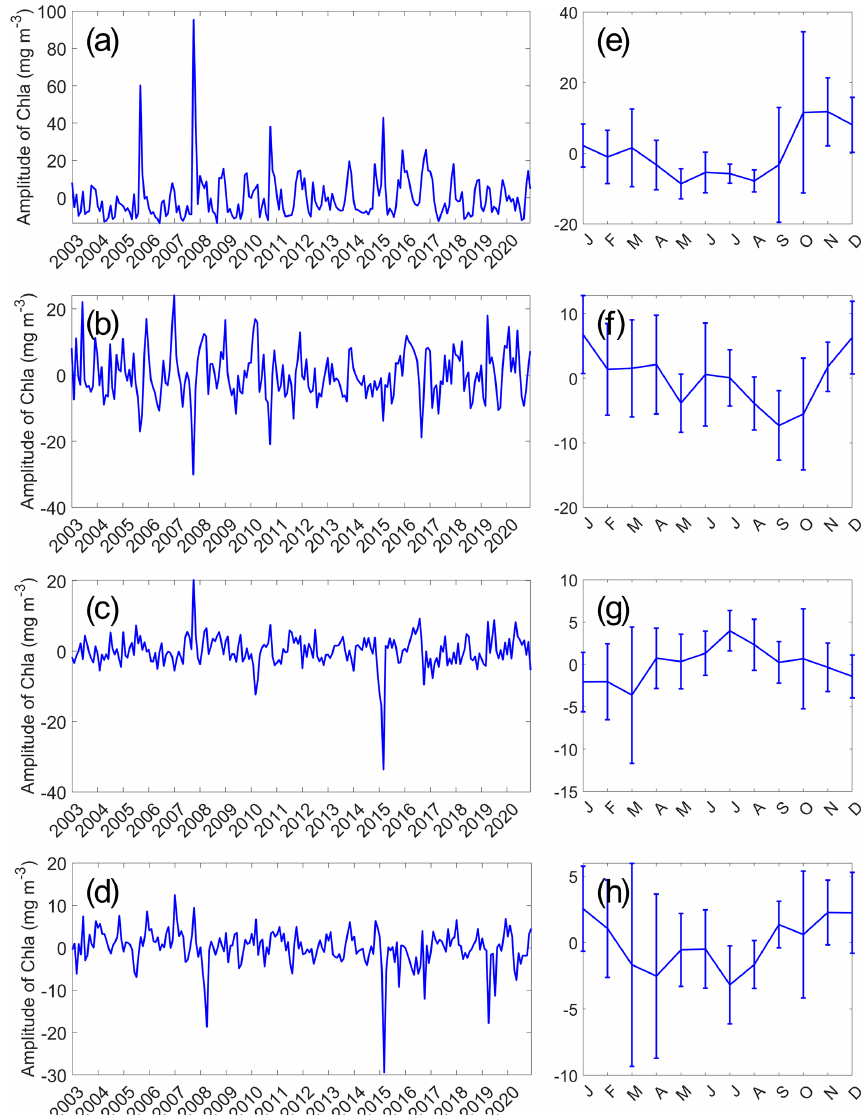
Figure 7. (a–d) Time series and (e–h) climatological mean of the first four EOFs for the Chl a concentration.